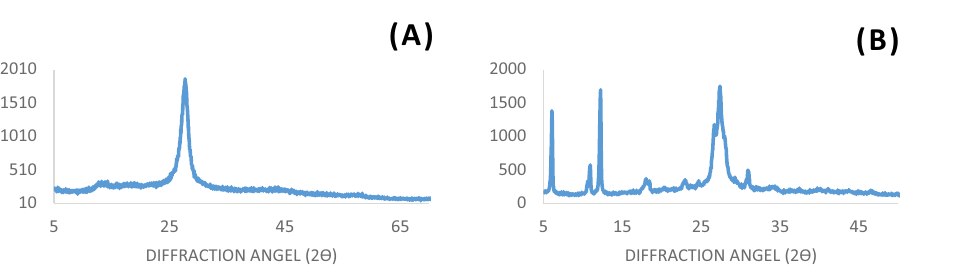
Figure 5. FE-SEM image of nanosheets g-C 3 N 4 ( a , b , c , and d ), and g-C 3 N 4 @l-arginine ( e , f , g, h ).